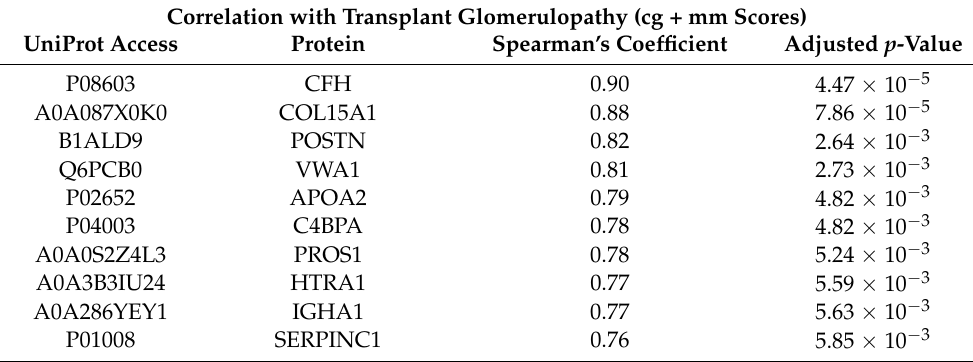
Table 5. Top-10 proteins positively correlated between their abundances by mass spectrometry and the Banff morphological scores cg + mm of chronic glomerular injuries. Correlation with Transplant Glomerulopathy (cg + mm Scores) UniProt Access Protein Spearman’s Coefficient Adjusted p -Value P08603 CFH 0.90 A0A087X0K0 COL15A1